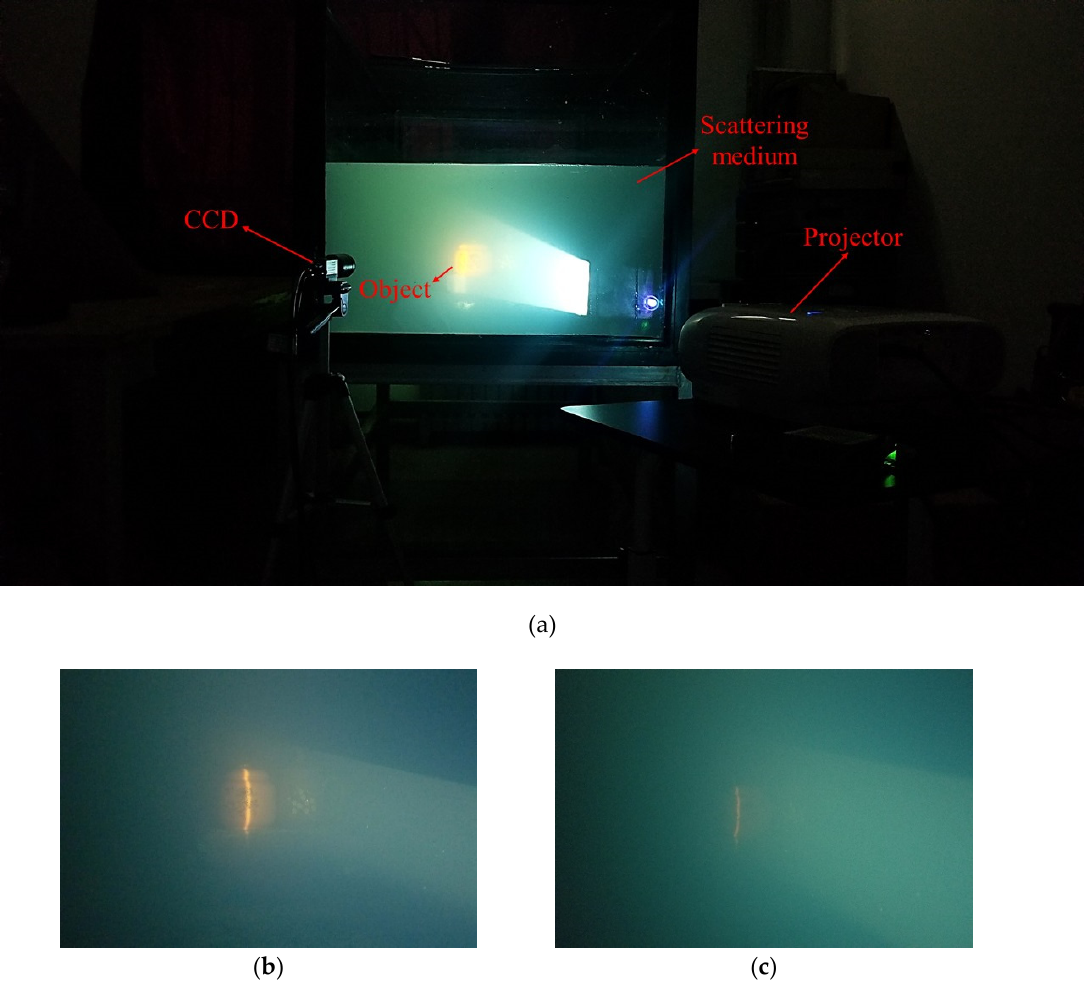
Figure 6. (a ) Experimental setup; ( b ) Scanning image with light turbidity water; ( c ) Scanning image with heavy turbidity water.